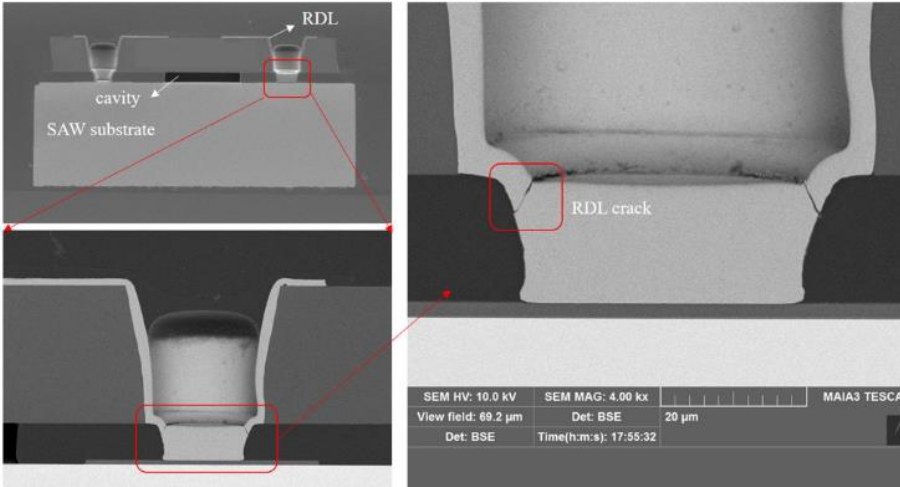
Figure 4. SAW filter package failure mode. (This refers to an RDL crack).